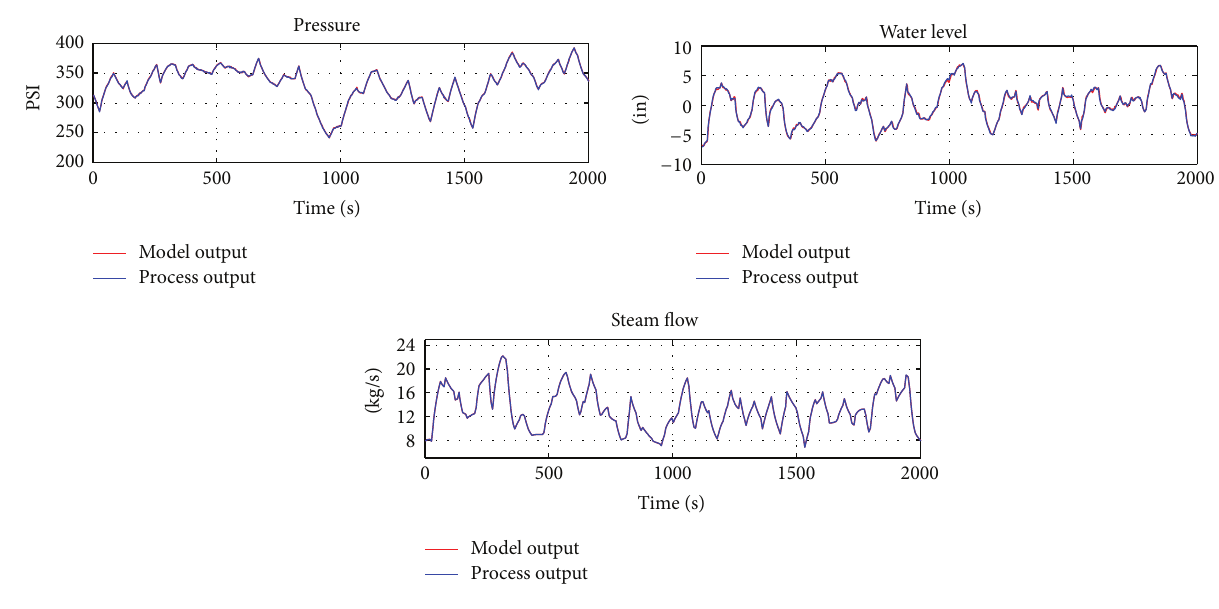
Figure 5: Validations of the fuzzy models.